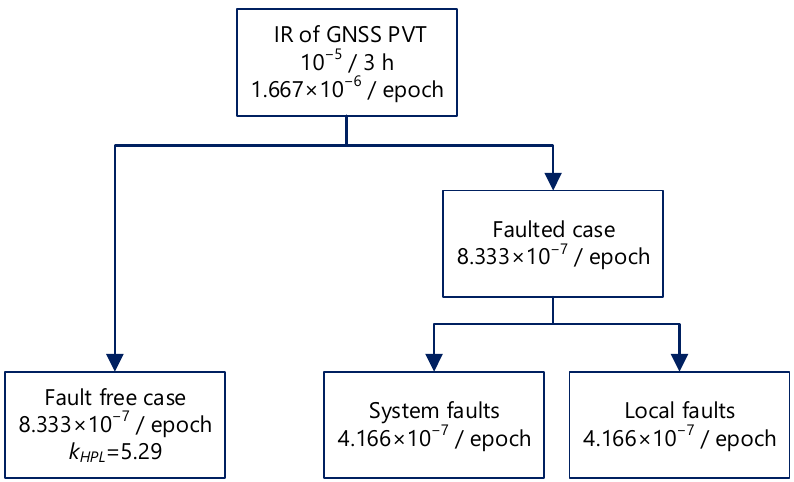
Figure 4. Integrity fault-tree branch allocating maritime integrity risk (based on [30]).